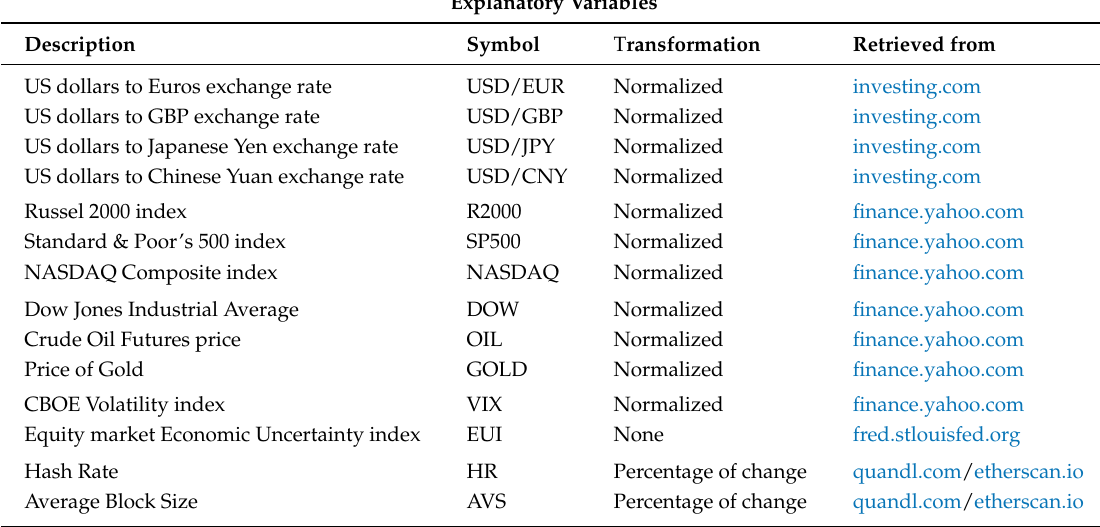
Table 1. List of explanatory variables along with the applied transformations and the online resources. The Hash Rate (HR) and Average Block Size (AVS) have been retrieved [55] for Bitcoin and from [56] for Ether.